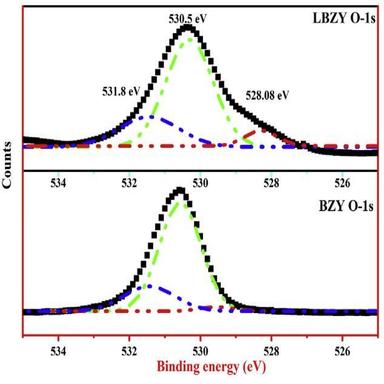
O-1s XPS analysis of BZY and La-doped BZY.